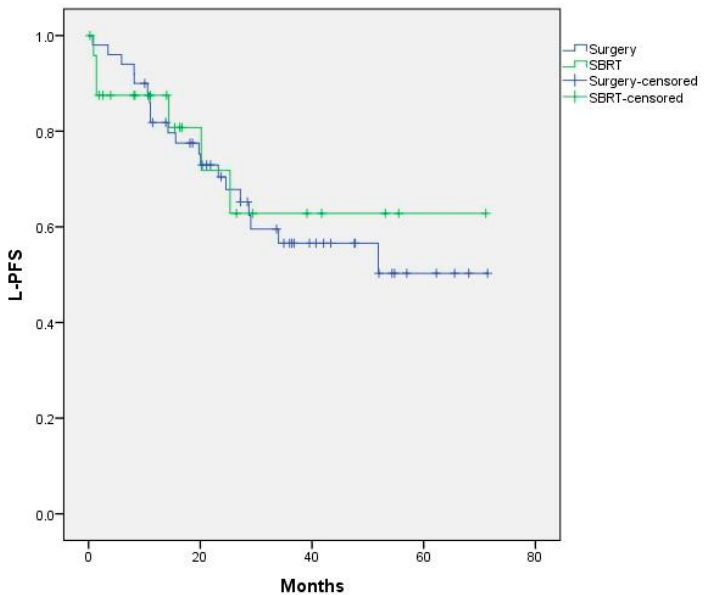
Figure 3. L-PFS curves for surgery vs SBRT. Median not reached. p = 0.809 .